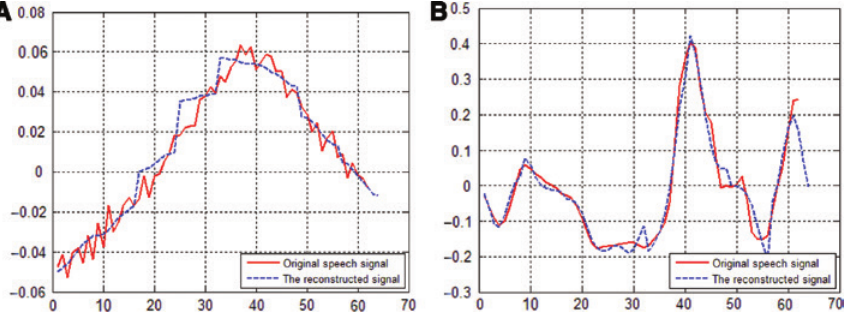
for Two Speech Frame with Energies. 30